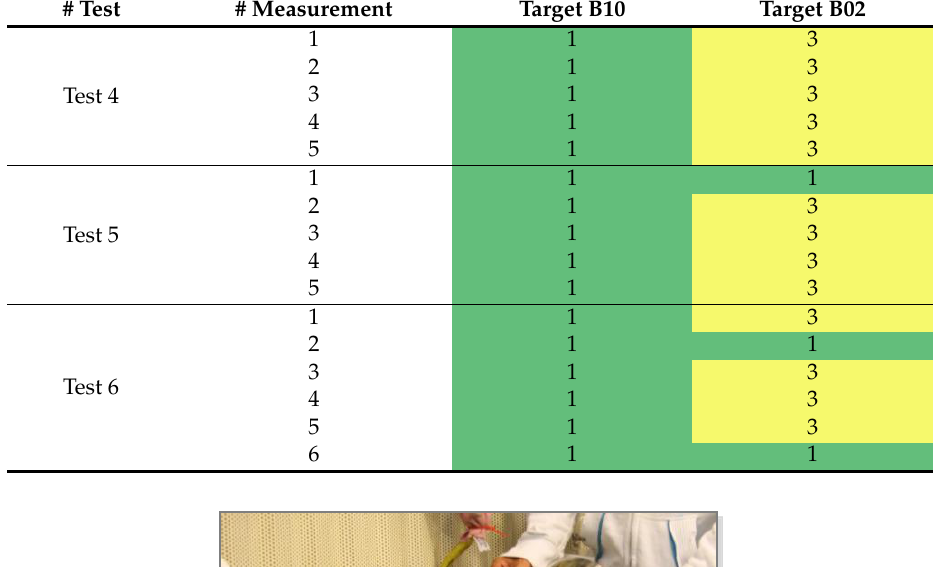
Table 11. Results of the three tests performed at FOI for target B02.